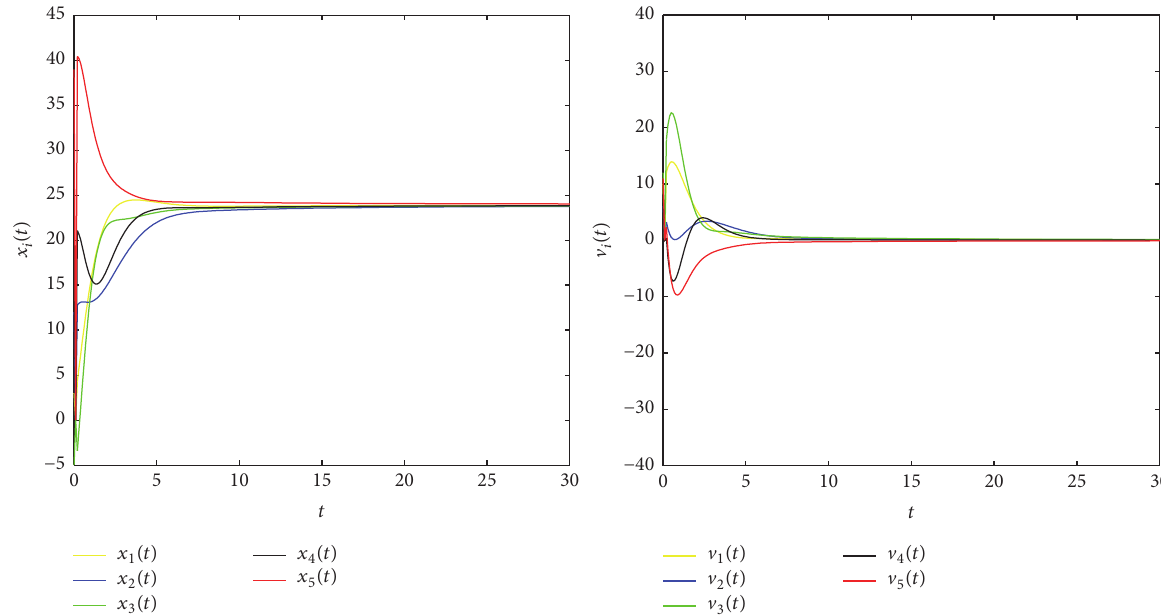
Figure 2: 𝑥 𝑖 (𝑡) and V 𝑖 (𝑡) of each agent with protocol (7), 𝛼 = 0.9 .